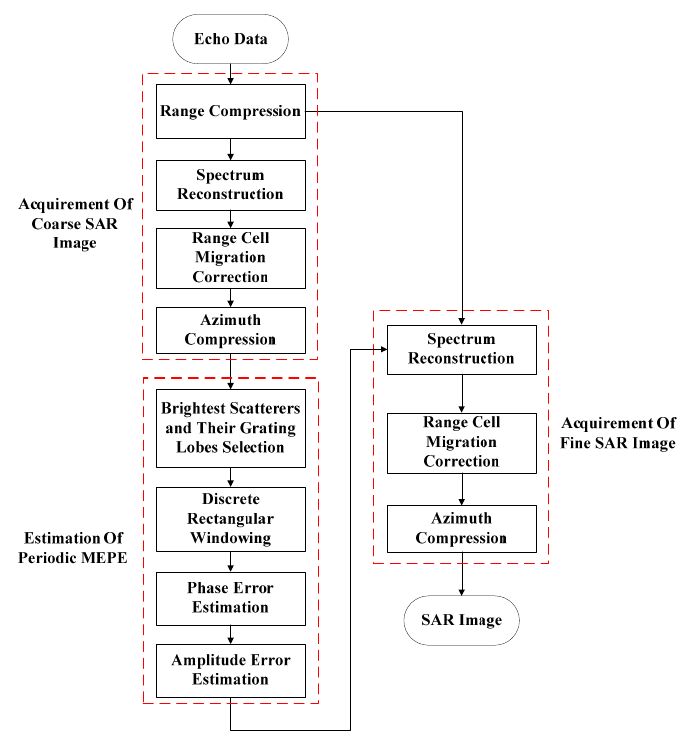
Figure 1. Flowchart for the developed GLS method.